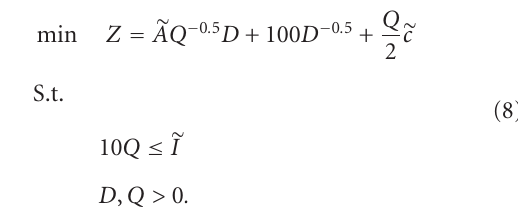
In the above equation, f ( · ) is the probability distribution function of the related antecedent